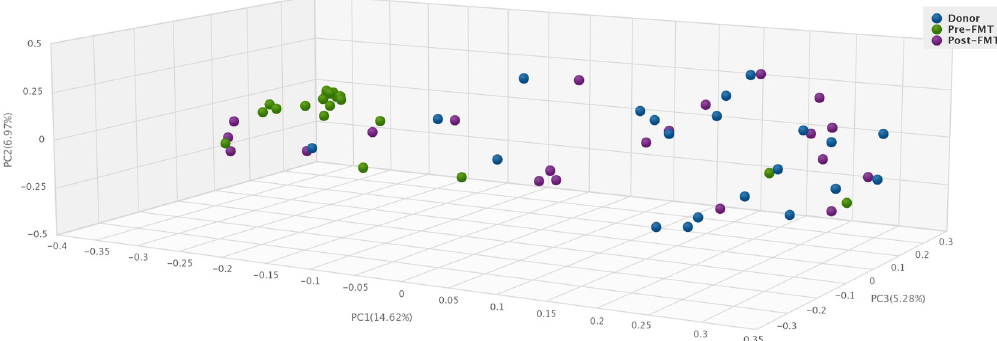
Fig 2. Beta diversity analysis using Bray-Curtis principle coordinate analysis demonstrates greater clustering of donor and post-FMT samples compared to pre-FMT samples.